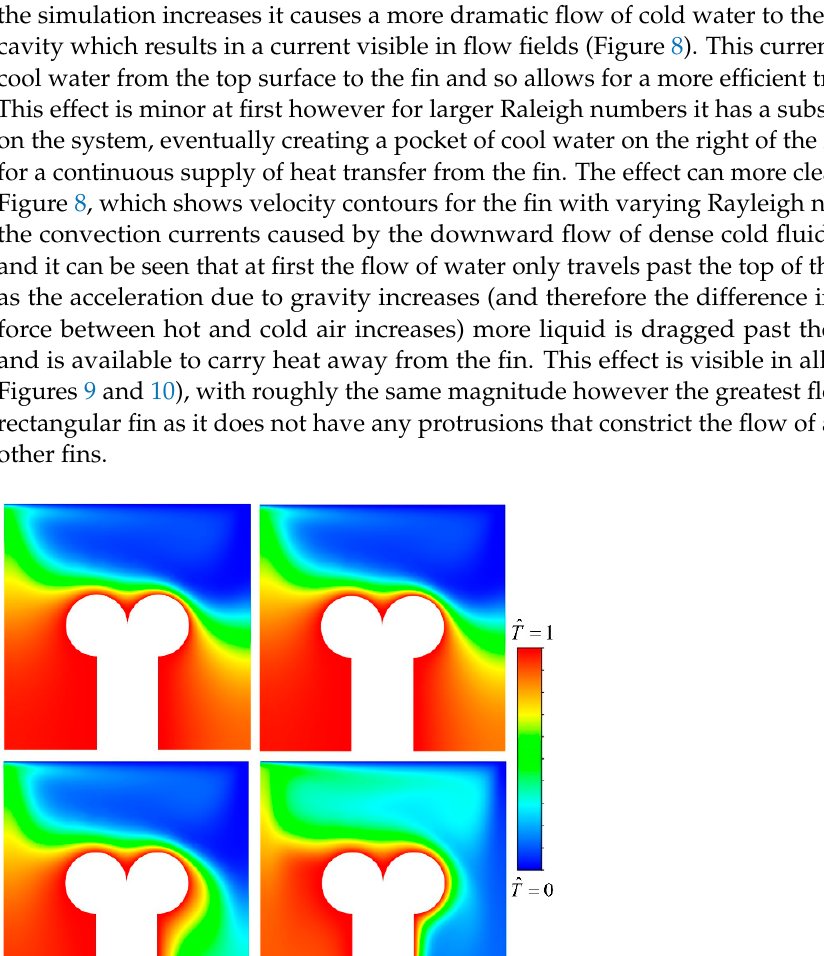
Figure 8. Velocity contours for the C2 fin with Re = 100 for varying Rayleigh numbers. From left to right, top to bottom: Ra = 10 3 , Ra = 10 4 , Ra = 10 5 , and Ra = 10 6 .